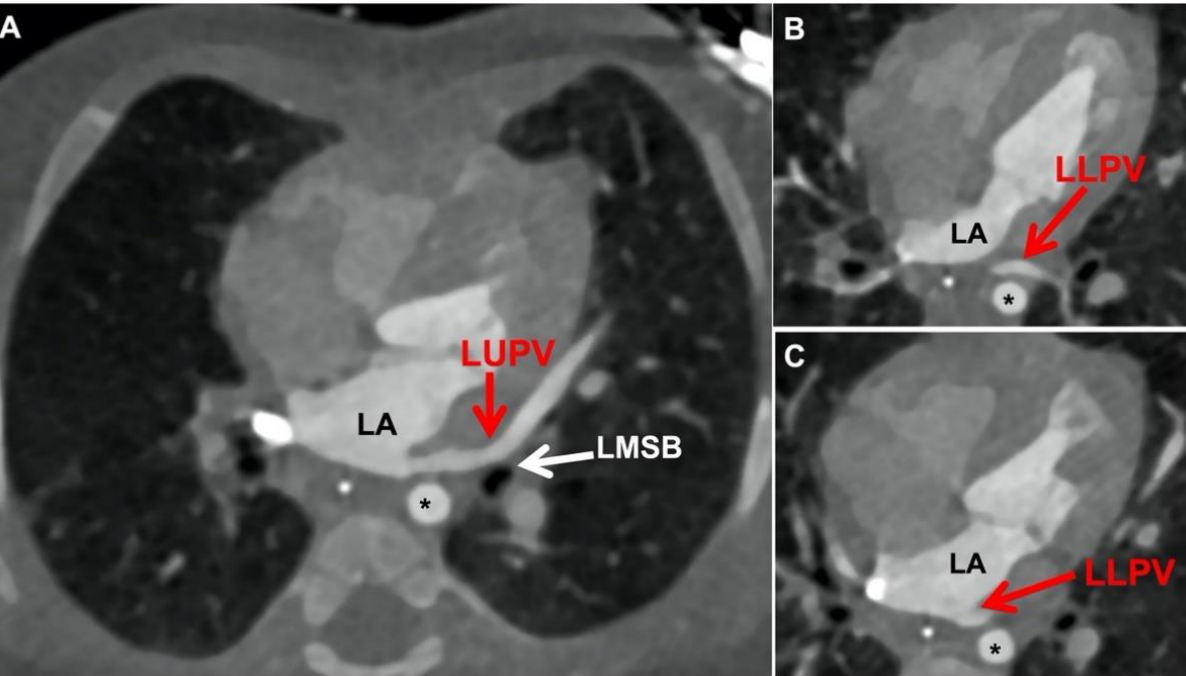
Figure 2. Left pulmonary veins (CT images). ( a ) Left upper pulmonary vein takes long, angulated course as it passes from lung parenchyma over left mainstem bronchus, across pericardial reflection into left atrium medially; ( b ) Left lower pul- monary vein courses anteriorly over the descending thoracic aorta taking an angulated course; ( c ) Left lower pulmonary vein crossing the pericardial reflection and entering far medially into left atrium. (LA = left atrium; LUPV = left upper pulmonary vein; LMSB = left mainstem bronchus; LLPV = left lower pulmonary vein; Asterisk = descending thoracic aorta).